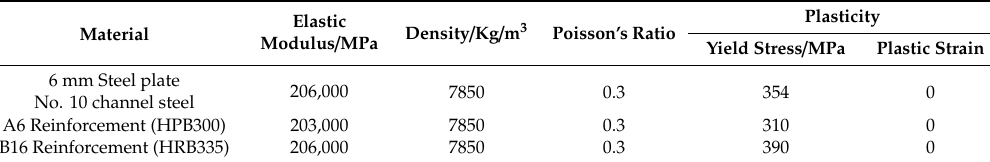
Table 7. Properties of steel.